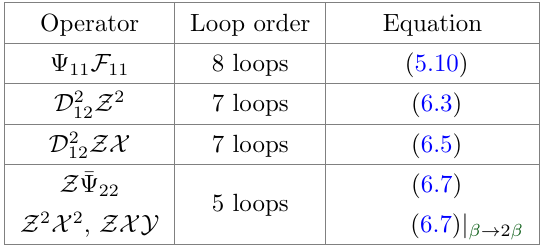
Table 2 . Our main results and where to (cid:12)nd them in the paper. The operator D 2 Konishi operator, while the operator Z 2 X 2 is the su (2) Konishi